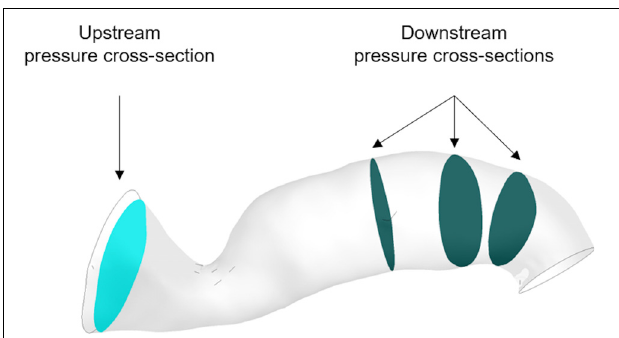
FIGURE 4 | Downstream and upstream pressure monitoring